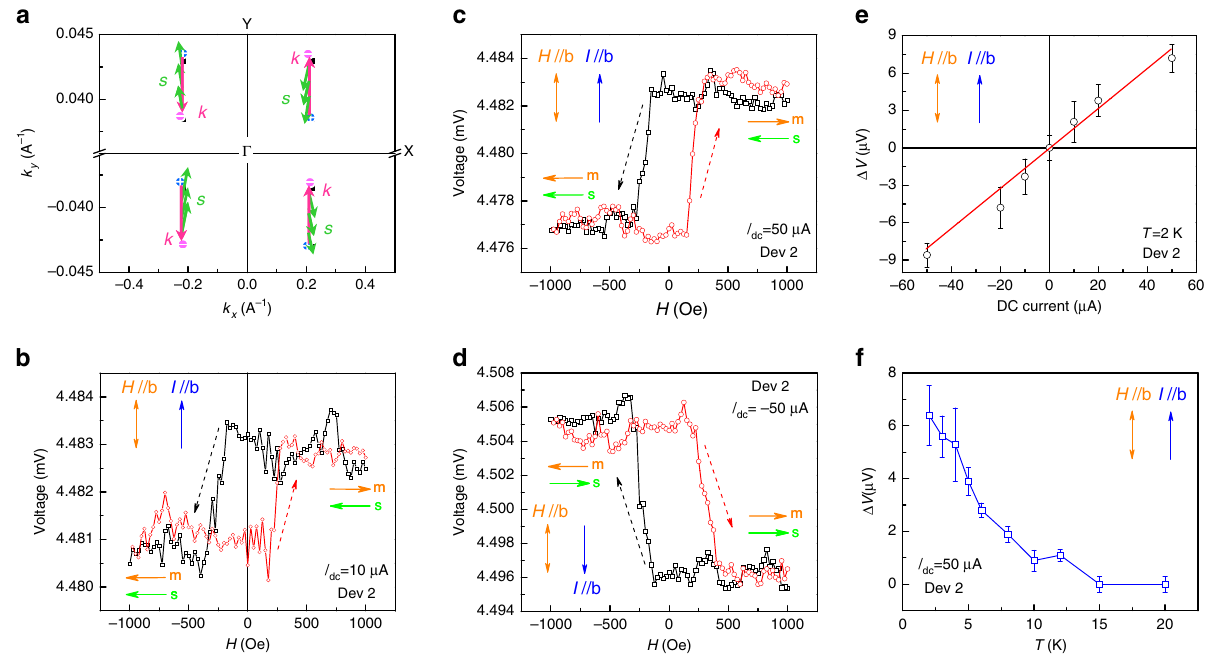
Fig. 3 Voltage hysteresis loop in b -axis WTe 2 /Al 2 O 3 /Fe tunnel junctions. a schematic of the spin – momentum locking of the topological Fermi arc in WTe 2 . The Weyl points with opposite chiralities are labeled as + (blue) and − (purple). The green arrow represents the spins. b – d The voltage hysteresis loop as a function of the in-plane magnetic fi eld under a different DC current ( T = 2 K). The DC currents in different panels are b : I dc = 10 μ A; c : I dc = 50 μ A; and d : I dc = − 50 μ A, respectively. The directions of the magnetic fi eld and current are indicated in the fi gures. The high- and low-resistance states are also illustrated by the relative orientation of the accumulated spin magnetic moment and moment of the ferromagnetic layer. e The voltage difference between the high- and low-resistance states as a function of the DC current. f The temperature dependence of the voltage difference between high- and low- resistance states ( I dc = 50 μ A). The error bars in e and f represent the noise of the fi eld dependence of the voltage hysteresis loop. The thickness of the WTe 2 in Device 2 is 23.0 nm. The error bars in e and f come from the noise in measured